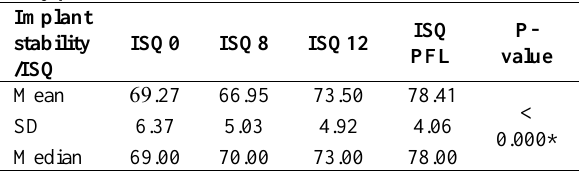
Table 2: The implant stability recorded throughout the study